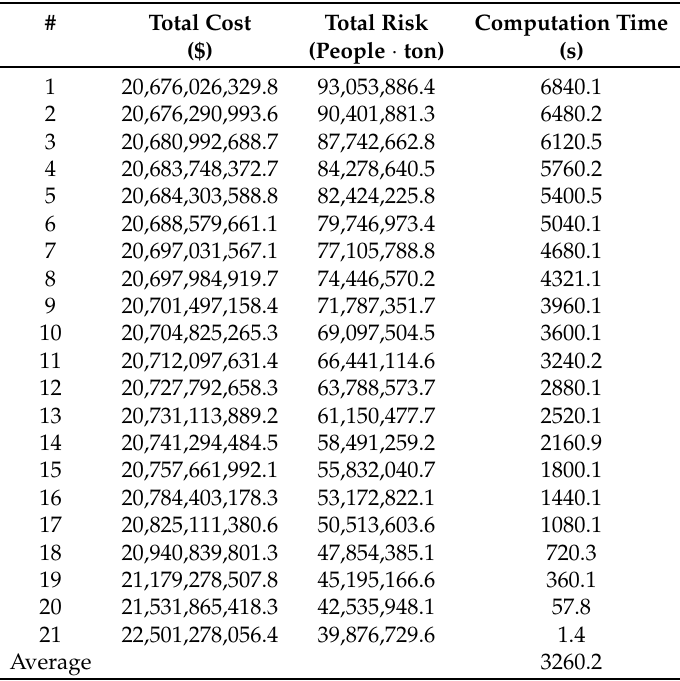
Table 4. Computational results of non-dominated